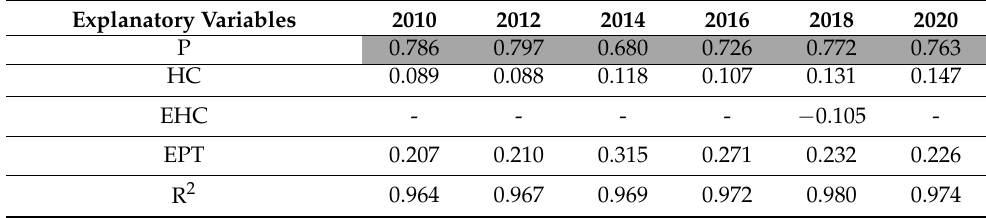
Table 12. Explanatory variables and their strength in the regression model of greenhouse gas